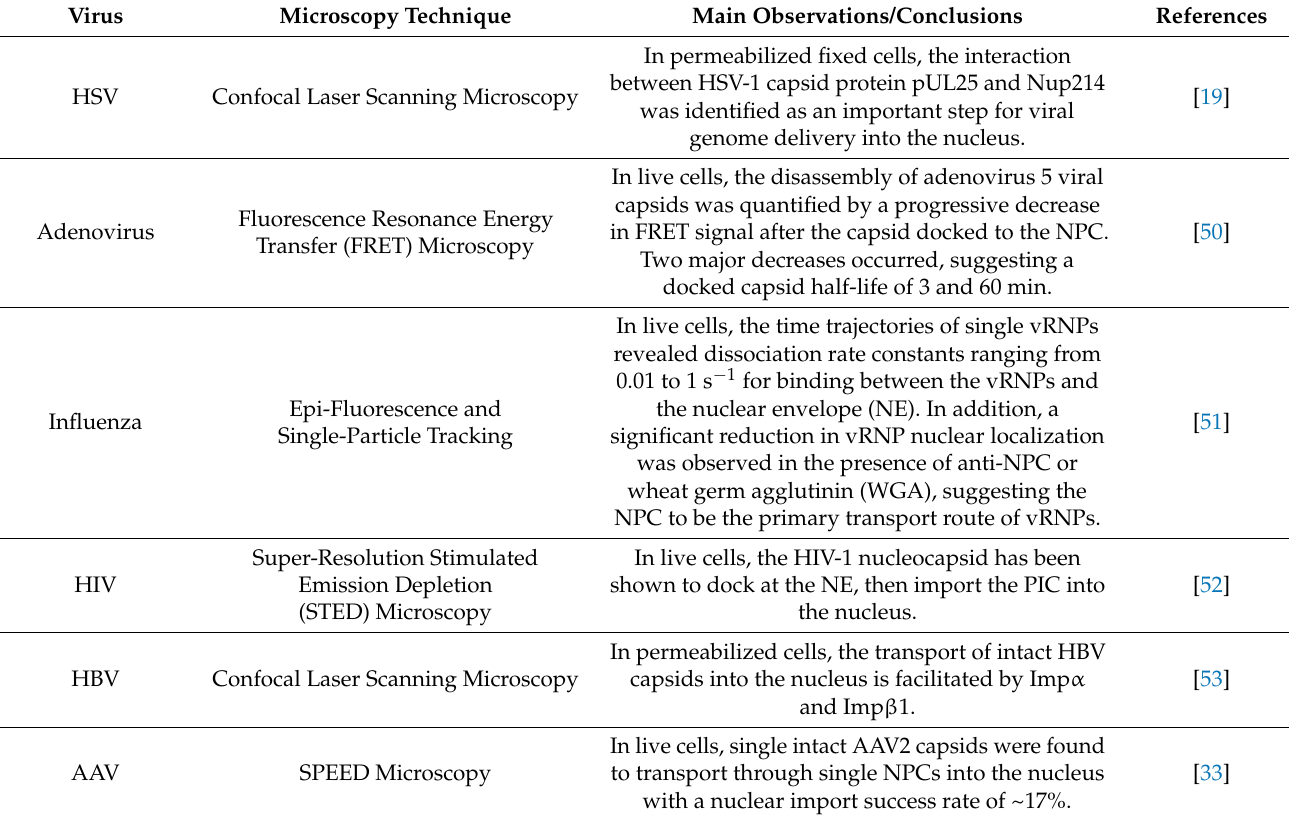
Table 1. Studies of virus–NPC interactions using a variety of fluorescence microscopy techniques. Included here is a non-exhaustive list of fluorescence microscopy techniques applied in the studies of nuclear transport of viral